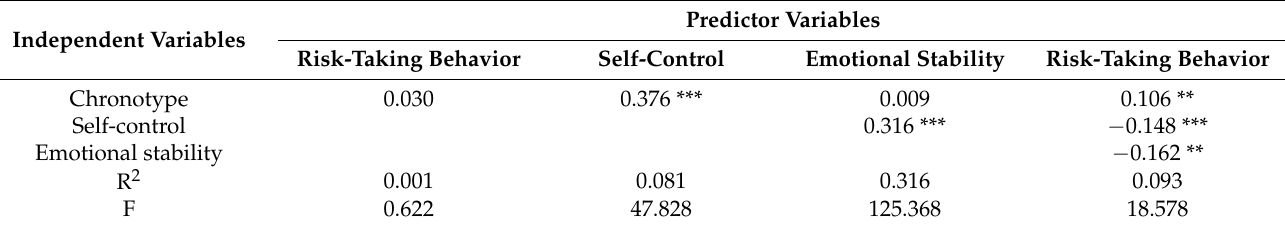
Table 2. The results from the mediation analyses.